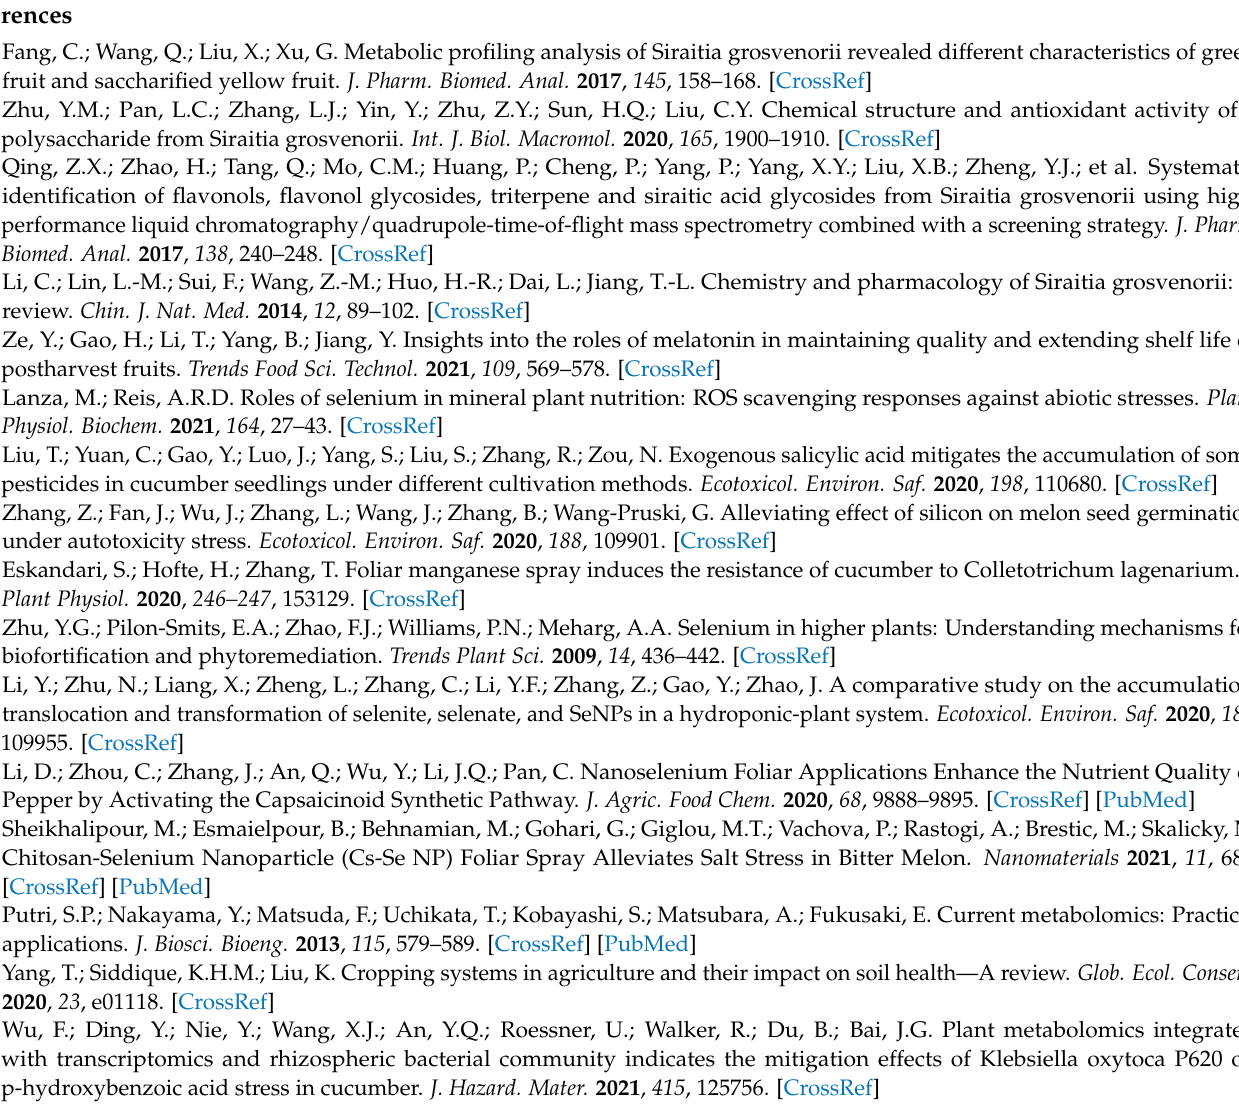
Table S5: Parameters for amino acids compounds analysis by UPLC-HRMS; Table S6: Qualitative compounds listed by GC-IMS analysis; Table S7: The contents of volatile compounds treated by control and nano-Se; Table S8: The identified metabolites with control and nano-Se